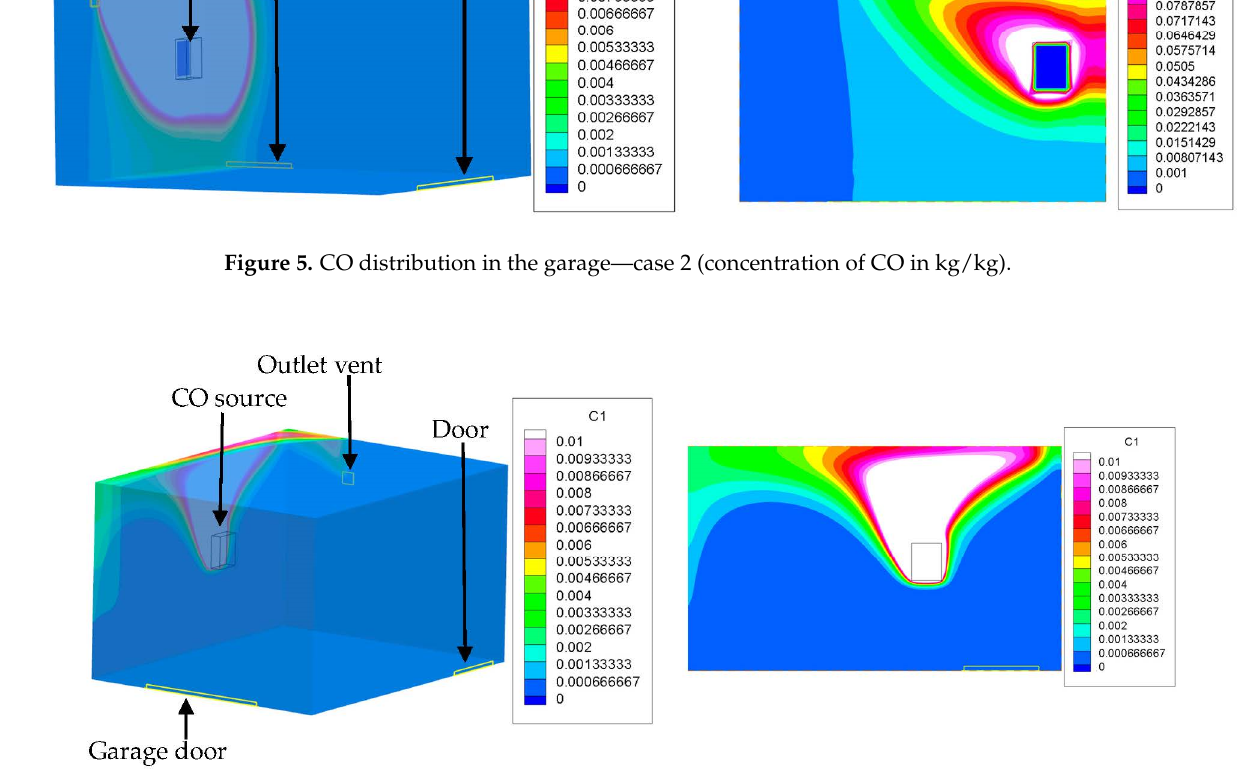
Figure 6. CO distribution in the garage—case 3 (concentration of CO in kg/kg).